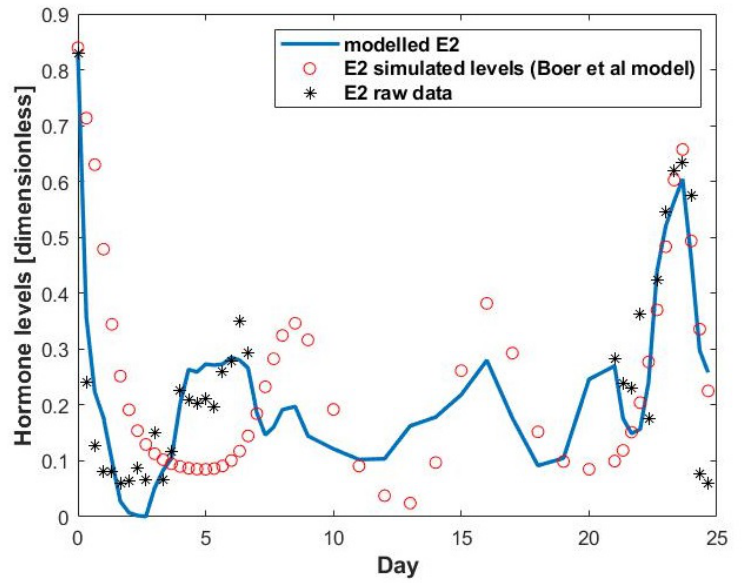
Figure 13. Modelled E2 output. The blue curve represents the modelled E2 from Equation (1). The black points are the raw data and the red points are the modelled E2 values from the model in